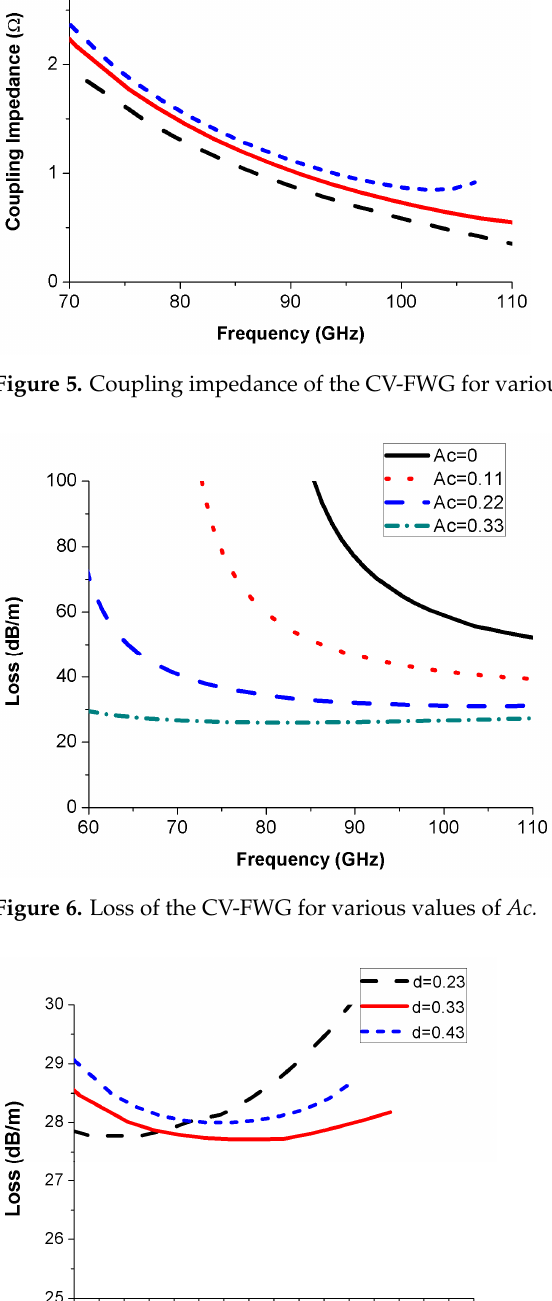
Figure 7. Loss of the CV-FWG for various values of d .